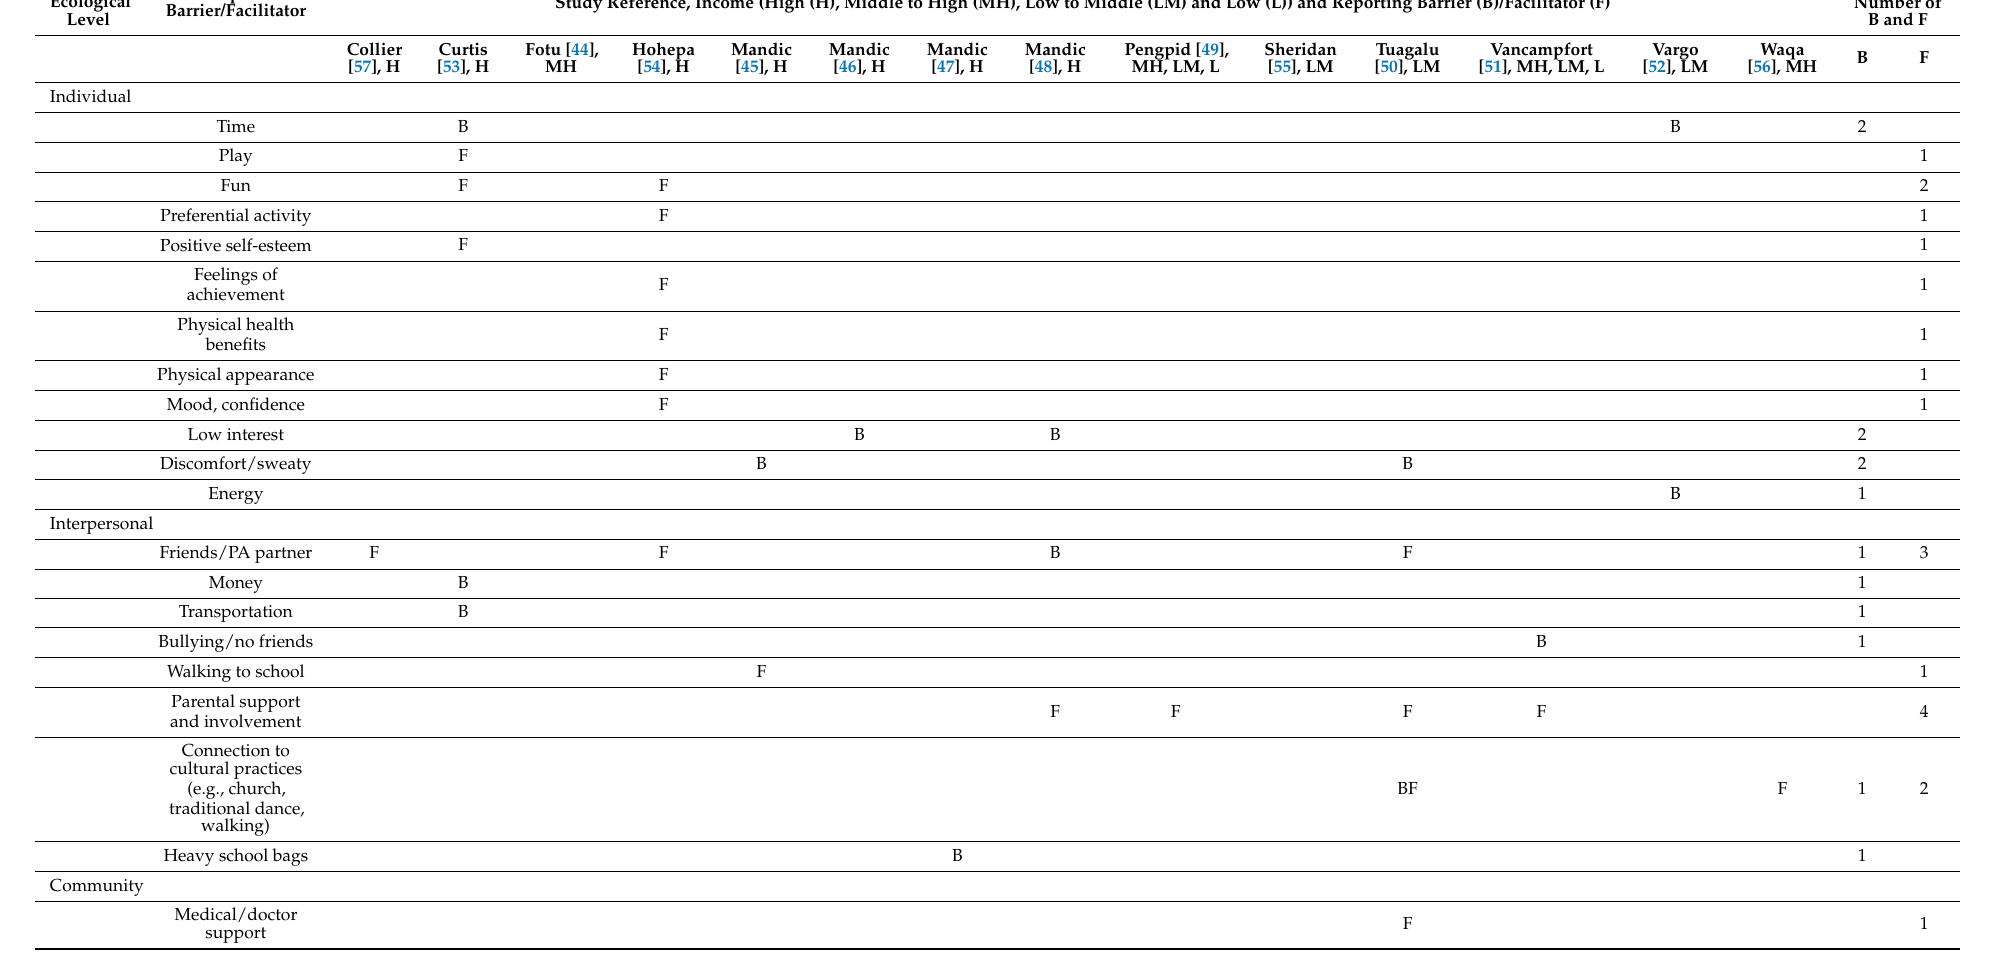
Table 3. Barriers (B) and facilitators (F) to physical activity and sport in a socioecological framework and each